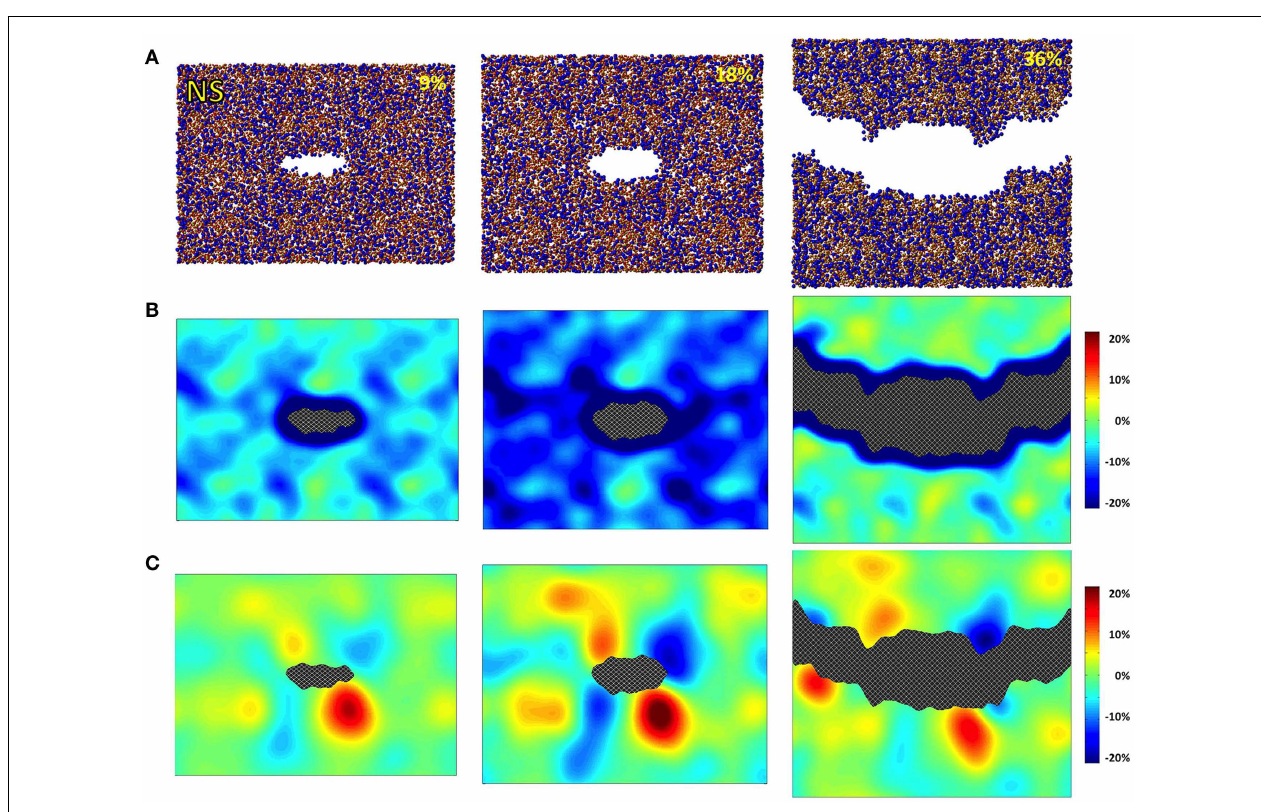
FIGURE 2 | Simulated sodium silicate (NS) under 9, 18, and 36% strains . (A) Snapshots of the atomic configurations. Silicon, sodium, and oxygen atoms are in gold, blue, and red, respectively; (B) local density change in percentage compared with the bulk density; (C) local shear